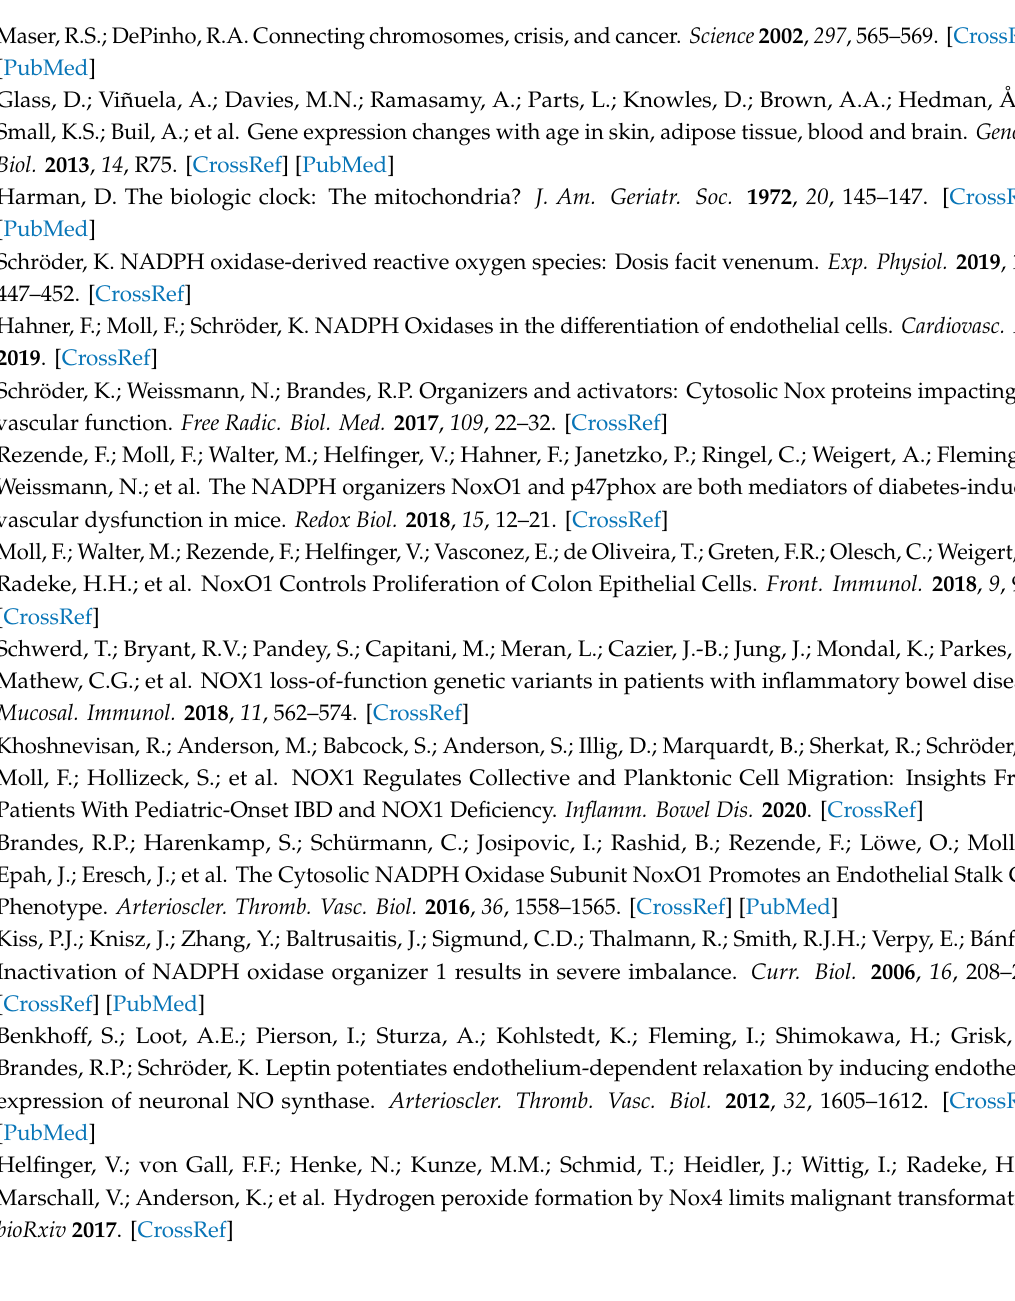
Figure S1A: Body weight of commercially available NoxO1 mutant mice. Figure S1B,C: AmplexRed measurement of colons from wildtype and NoxO1- / - mice. (B) representative picture; (C)